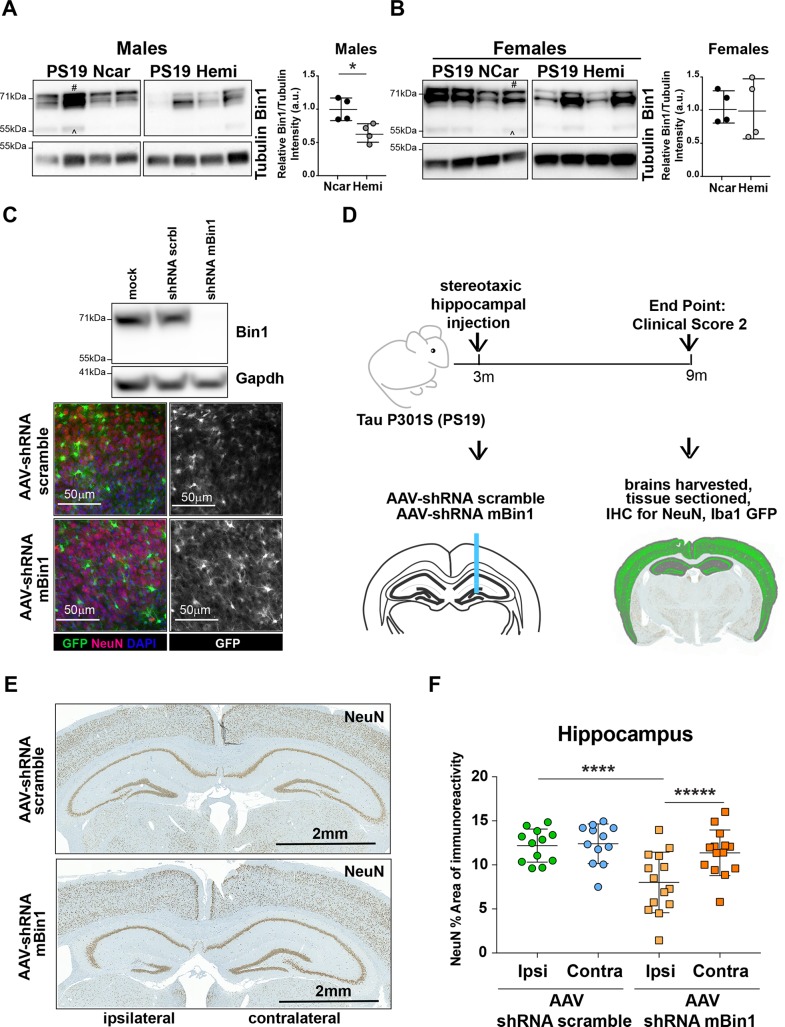
Acute knock-down of Bin1 in the hippocampus of PS19Hemi mice results in neuronal loss.(A) (B) Western blotting of brain lysates from male and female PS19Ncar and PS19Hemi mice showing Bin1 expression. Tubulin represents loading control. # indicates neuronal Bin1 isoform 1. ^ indicates ubiquitous Bin1 isoform 2. Plots show Bin1 levels normalized to tubulin in male and female mice, respectively. Each circle represents one animal. Unpaired Student t test: p-value: * p< 0.05; ** <0.01; *** p<0.001. (C) Top: western blot shows Bin1 expression in lysates from hippocampal organotypic slice cultures infected with AAV (1/8)-GFP-shRNA scrbl and AAV (1/8)-GFP-shRNA mBin1 on DIV 3 and harvested at DIV 9. Gadph represents loading control. Bottom: immunofluorescence images of hippocampal slice cultures infected with AAV (1/8)-GFP-shRNA scrbl and AAV (1/8)-GFP-shRNA mBin1 and immunostained for NeuN (neuronal marker) as well as GFP (infected cells) and DAPI (nuclear marker). Scale bar: 50μm. One representative image per condition. (D) Schematic and timeline of AAV injection paradigm. Inset image shows NeuN stained coronal section, with gray region highlighting total area annotated for neuropathology while green highlights NeuN staining in these regions. (E) Immunohistochemical staining of NeuN in hippocampi of PS19Hemi mice injected with AAV (1/8)-GFP-U6-shRNA scrbl and AAV (1/8)-GFP-U6-shRNA mBin1, respectively. One representative image per group. Scale bar: 2mm. (F) Plot representing the percent area of NeuN immunoreactivity in the ipsilateral and contralateral hippocampus (area of NeuN immunoreactivity normalized to the total area of the ipsilateral or contralateral hippocampus, respectively, for each animal). Circles represent animals injected with AAV (1/8)-GFP-U6-shRNA scrbl: green filled circles represent ipsilateral hemisphere; blue filled circles represent contralateral hemisphere. Squares represent animals injected with AAV (1/8)-GFP-U6-shRNA mBin1: yellow filled squares represent ipsilateral hemisphere; red filled squares represent contralateral hemisphere. Each circle/square represents one single animal. A linear mixed effect model with a 2-way fixed effect model with interaction, a random intercept, and a compound symmetric within-subject correlation structure was employed. Post-hoc comparisons were analyzed between ipsilateral and contralateral hemispheres within animals, as well as between ipsilateral hemispheres across groups and contralateral hemispheres across groups. P-values were adjusted via the glht single step method: Adjusted p-value: * p< 0.05; ** <0.01; *** p<0.001; **** p<0.0001; ***** p<0.00001.